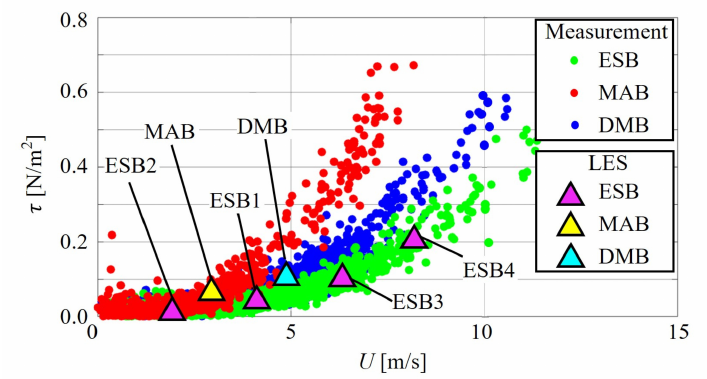
Figure 7. Wind stress τ versus mean velocity U at three beaches, i.e., location B in cases ESB1–ESB4, location D in case MAB, and location F in case DMB. The measurement data at the same locations are